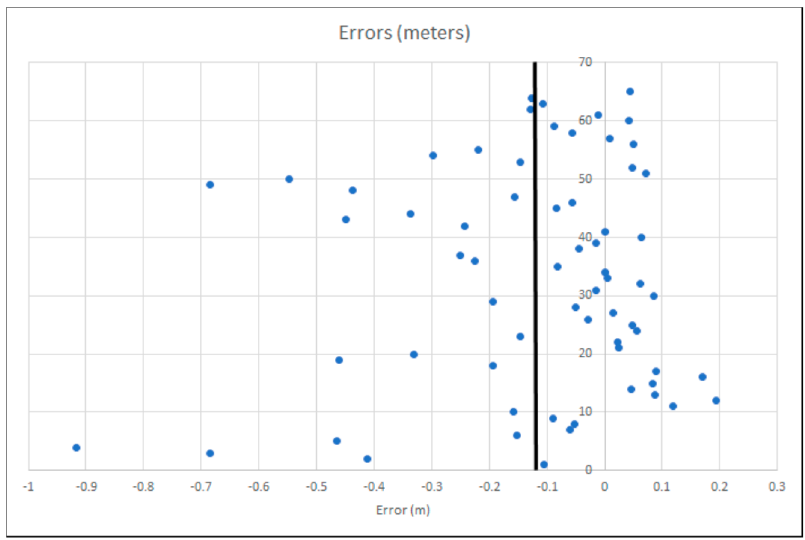
Figure 8. The horizontal axis shows the distribution of the 65 error pairs. The vertical line represents the mean of − 12.11 cm.